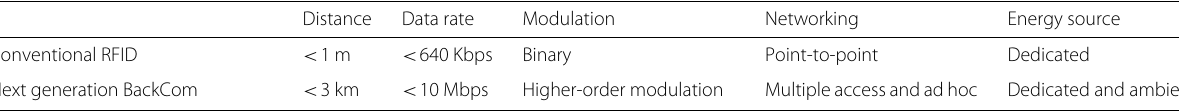
Table 1 Comparison of conventional and next generation BackCom